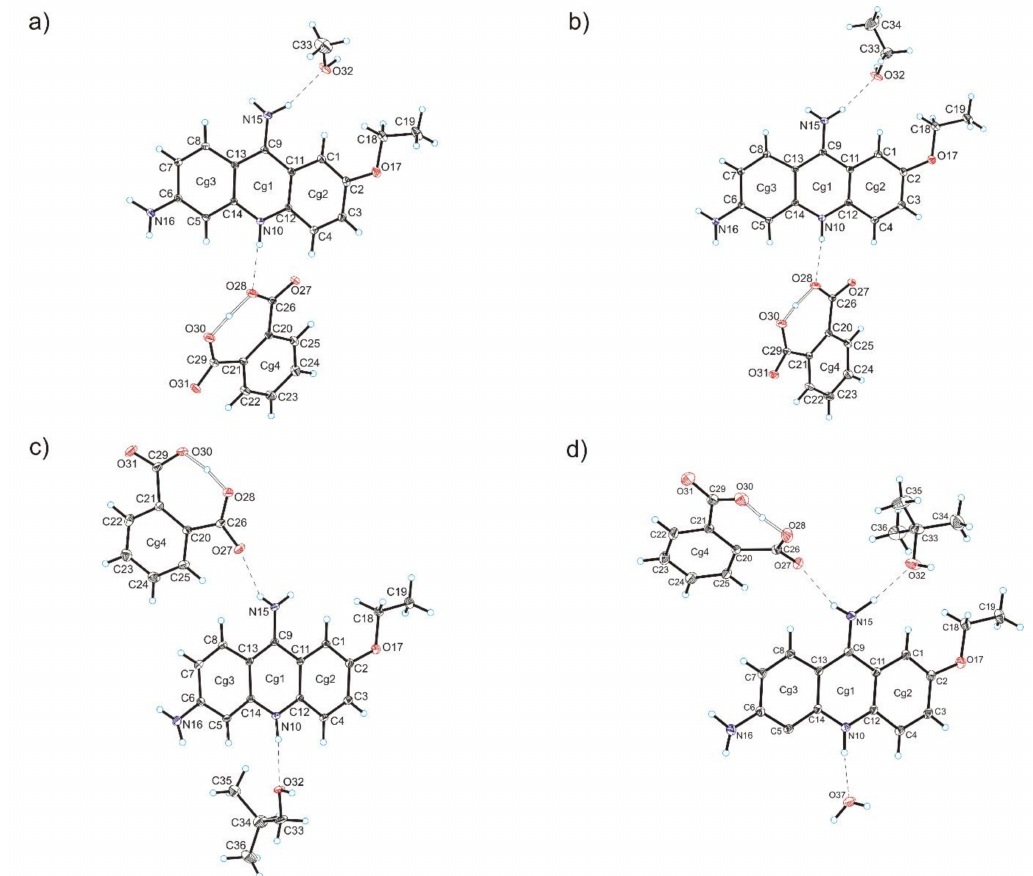
Figure 1. Crystal structures of compounds 1 – 4 ( a – d ) with the atom-labelling scheme (hydrogen bonds are represented by dashed lines). Cg1, Cg2, Cg3 are the ring